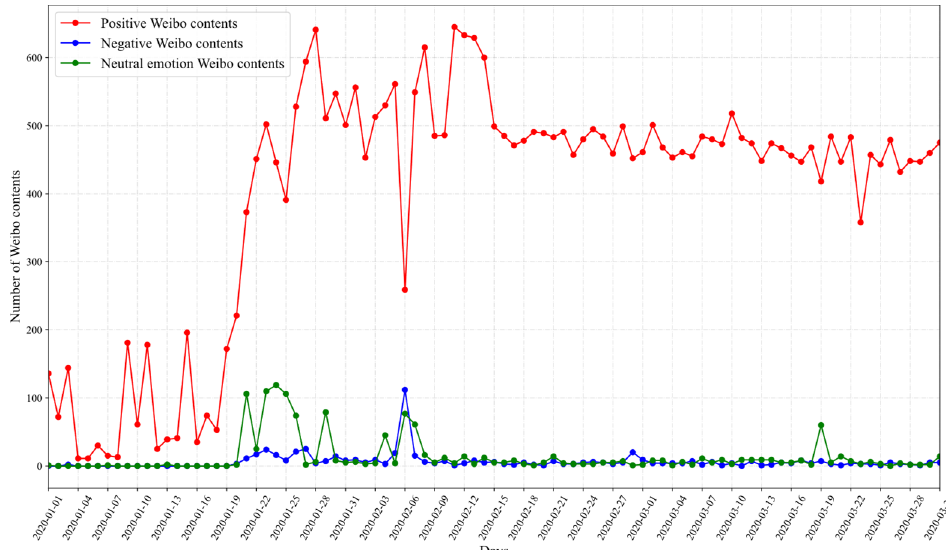
Figure 8. The daily textual sentiment change chart on the Sina Weibo platform.